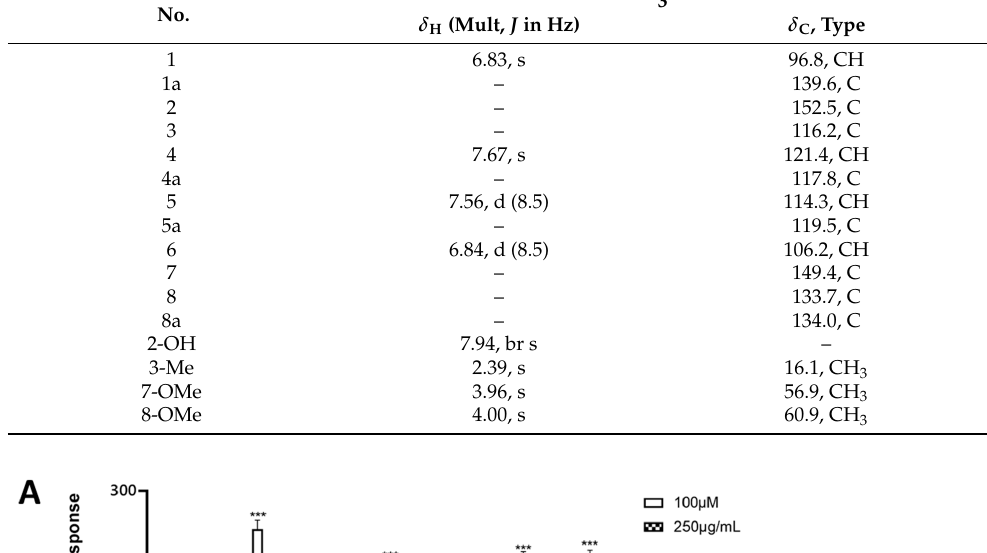
Table 3. 1 H NMR (600 MHz) and 13 C NMR (150 MHz) spectroscopic data of 3 in CDCl 3 .